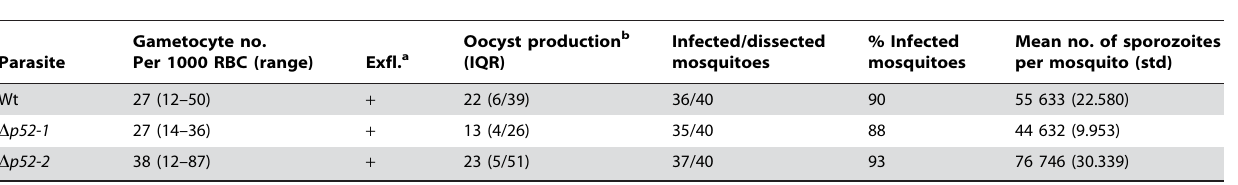
Gametocyte no. Parasite Per 1000 RBC (range) Exfl. a